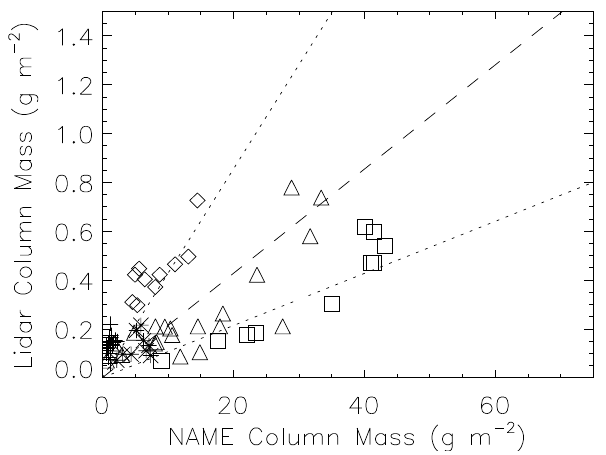
Fig. 10. Comparison between the CIMLs from NAME simulations and estimates from the FAAM lidar. The symbols are; 3 km layer 5 th May (crosses); 5 km layer 5 th May (stars); 14 th May (diamonds); 16 th May (triangles) and 17 th May (squares). The dashed line shows y =0 . 028 x , the dotted lines have gradients of twice and half that of the dashed line.